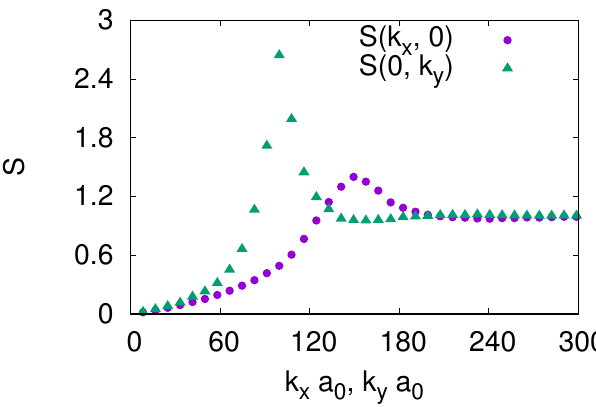
) computed for x = 350, ,0 ) and S ( 0, k x y